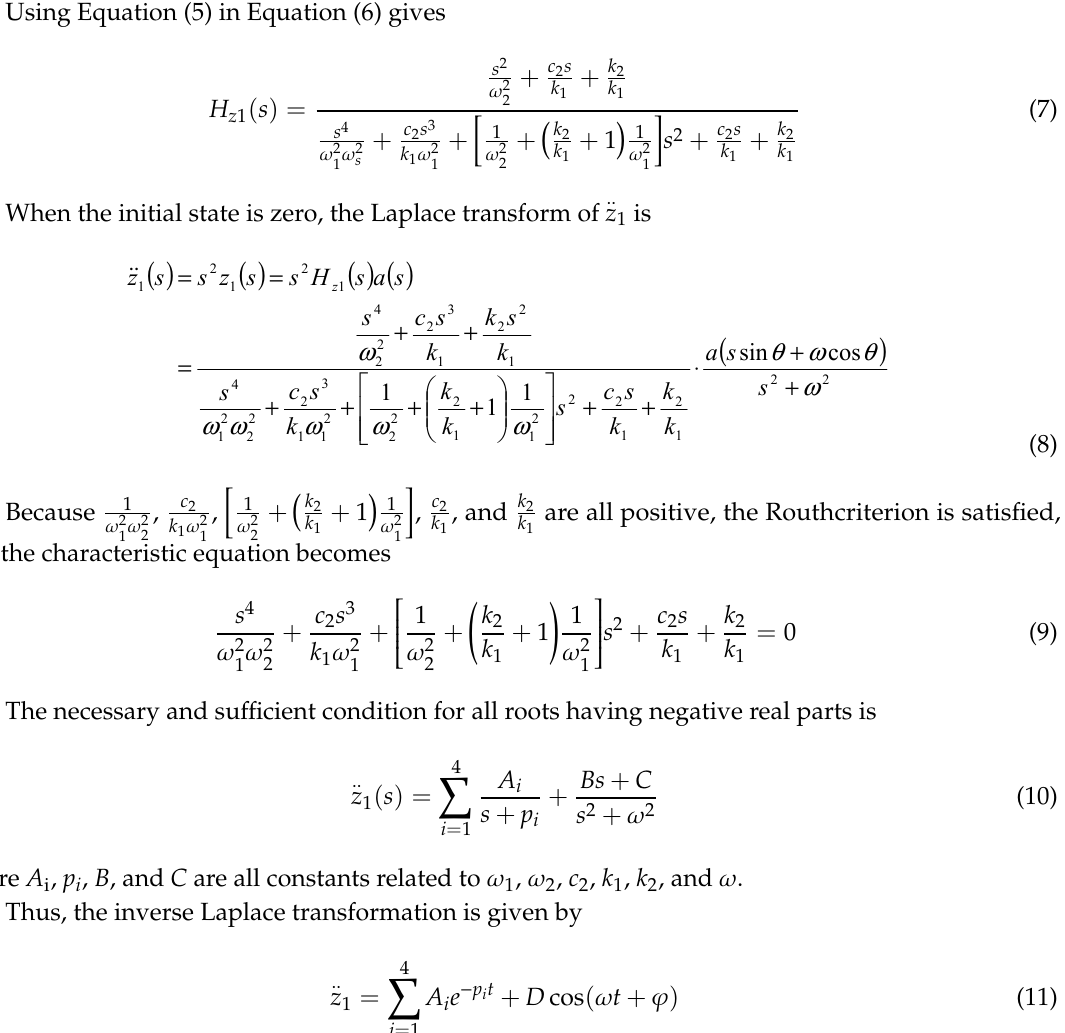
model of the vehicle-track coupled system shown in Figure 2a, a numerical model of a vehicle-track coupling system was developed, representing a passenger car running on a slab track. The simulation is implemented by using both Universal Mechanism (UM) and ANSYS